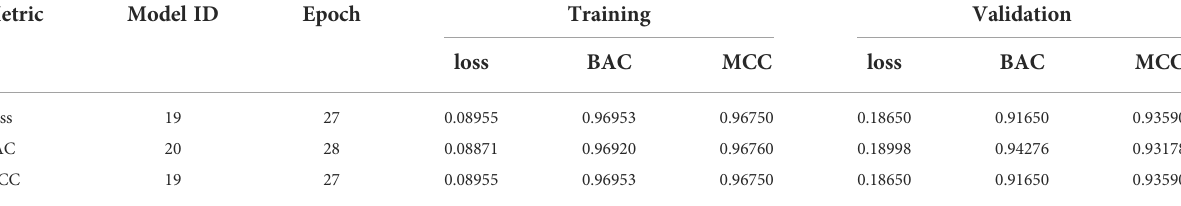
TABLE 2 The three best models after training based on loss, balanced accuracy and Matthews correlation coef fi cient.